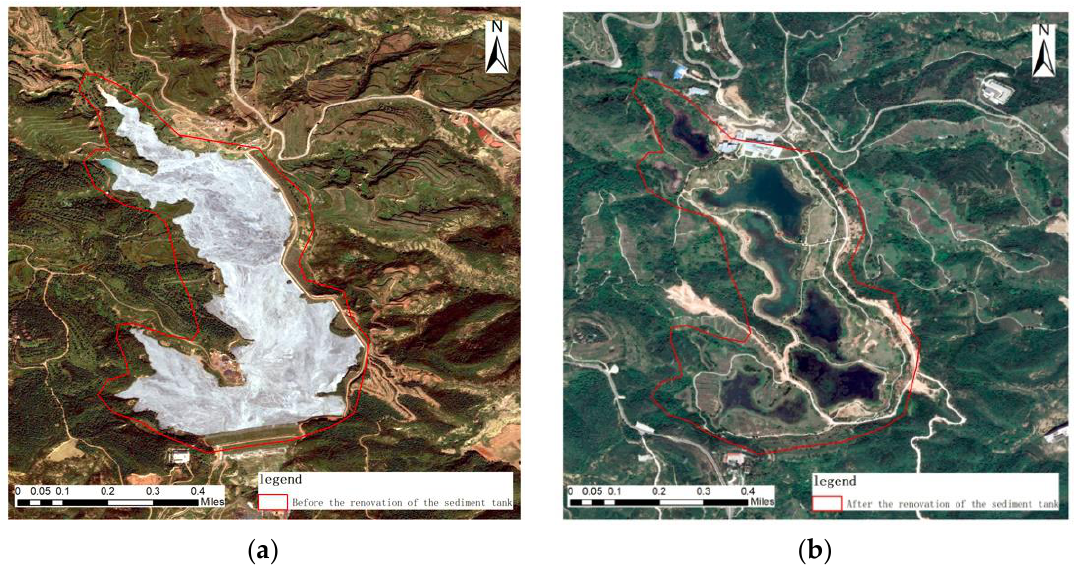
Figure 10. Remote sensing images before and after ecological restoration in the ash pool reconstruc- tion area. ( a ) before treatment; ( b ) after treatment.